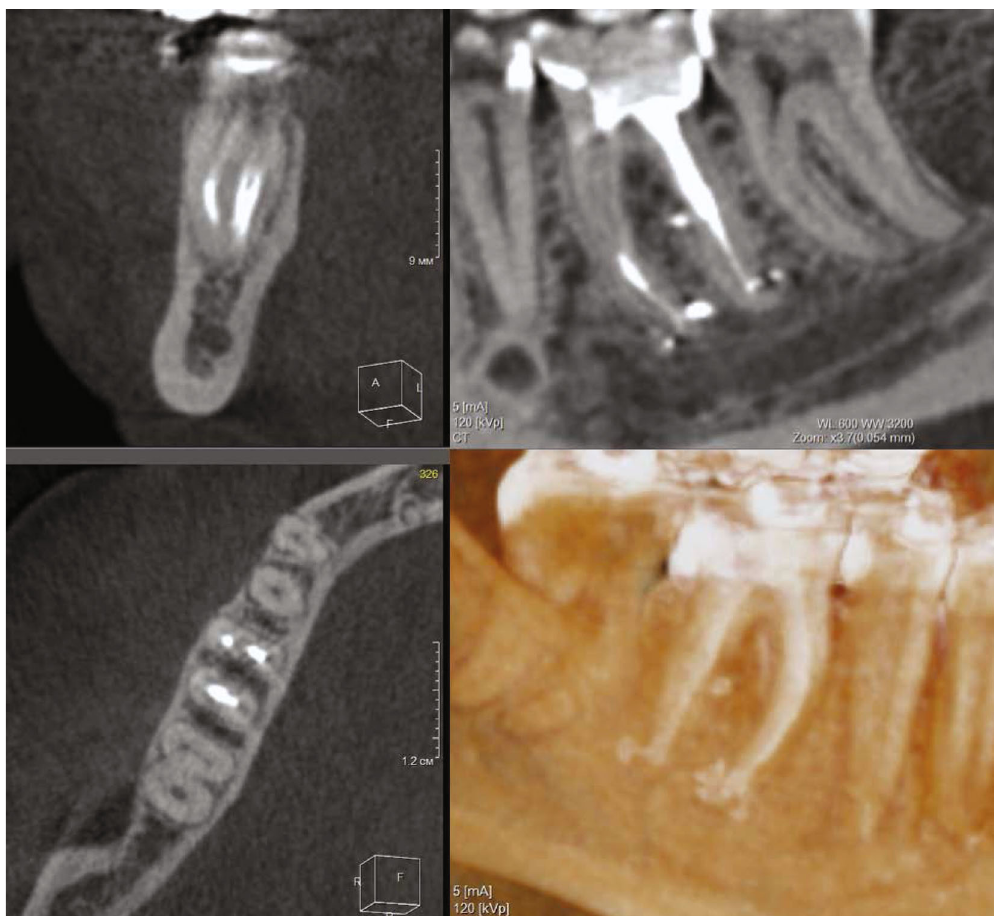
Figure 5: CBCT scan of tooth # 46 in 48 months after obturation. Full bone recovery is